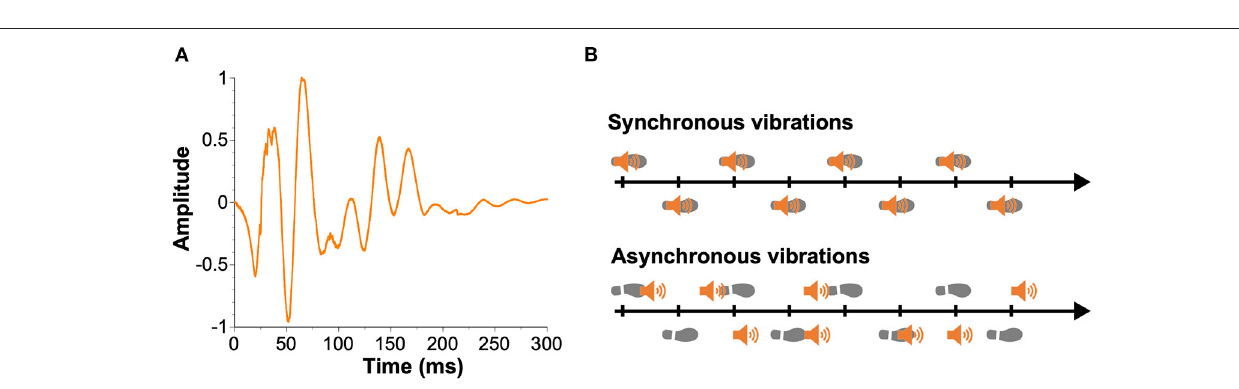
(ART) (ANOVA-ART) procedure (Wobbrock et al.,